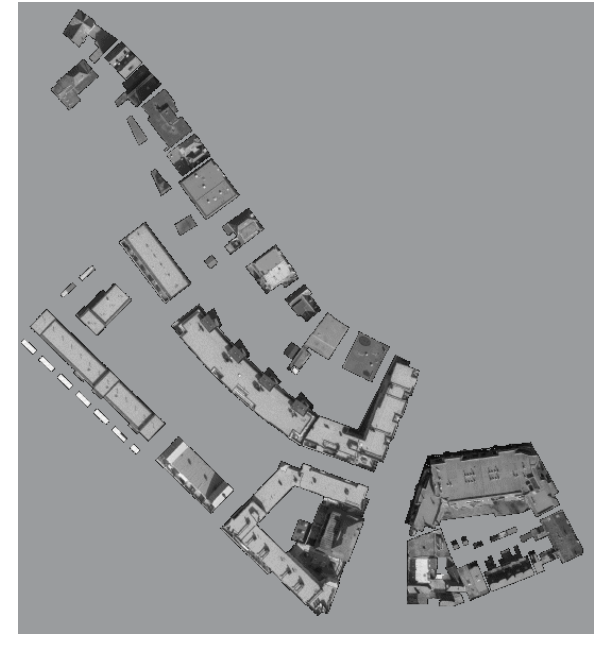
Figure 3: Building (roof) objects 2010